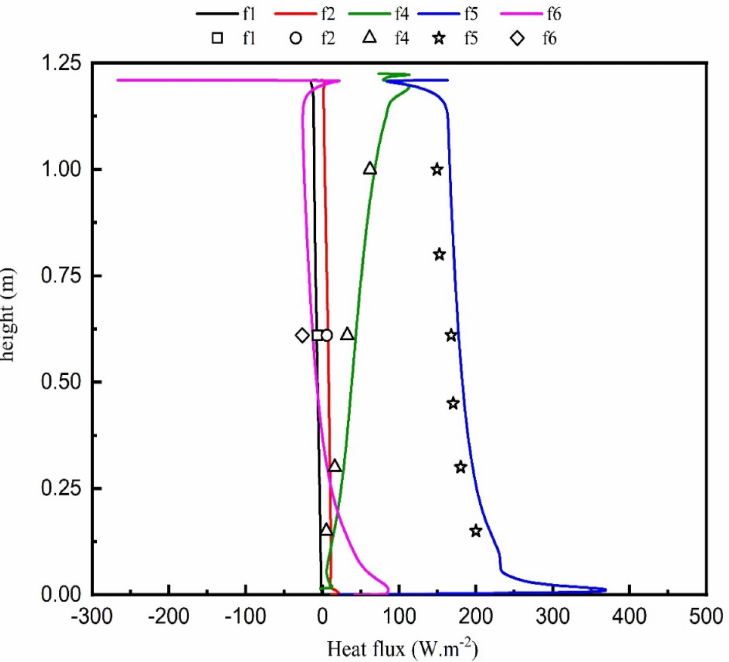
Figure 16. Experimental and numerical heat flux profiles for the three glazings, according to k-w models, P = 190 W.m − 2